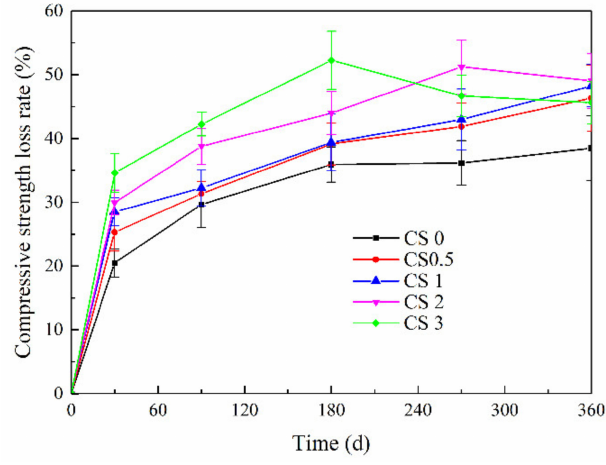
Figure 4. The loss rate of compressive strength of concrete specimens against corrosion time. The observable damage changes after the compressive strength tests of samples after 180 and 360 d of salt corrosion showed that after 180, there were fine cracks at the CS0 samples edges (Figure 5). As the Na 2 SO 4 concentration increased, surface cracks gradually emerged and became dense; these cracks further expanded and becoming thicker and longer. The position of these cracks migrated toward the center of the specimens, especially in CS3 solution, where the cracks developed an “X” shape, and a small amount of peeling appeared on the surfaces. After 180 or 360 d of exposure, changes in sample surface cracks in the CS0 solution were not very significant. As the Na 2 SO 4 concentration increased, the surface cracks on the sample in the CS1 solution adopted a “V” shape, which shifted toward the center of the sample. There were many small cracks in the CS2 samples, which were cross-connected with each other. Numerous intersecting cracks appeared in the CS3 samples, and the surface peeling phenomenon relatively serious.